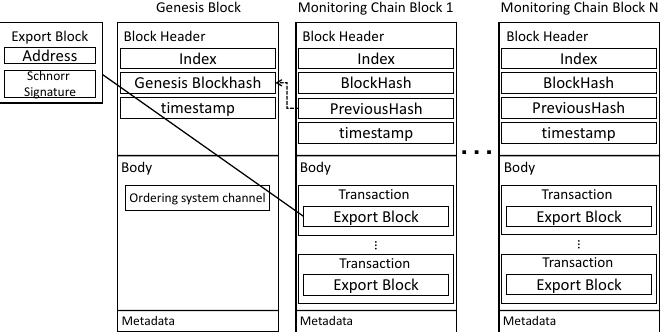
Figure 6. Monitoring-Chain block: Structure of Block mc implemented based on HF . After saving the DFS to lighten the IC , Address ic , and Sig schnorr , Sig pub is saved. Signature, Index, and TxValidation- Code of Node mc are stored in Metadata.